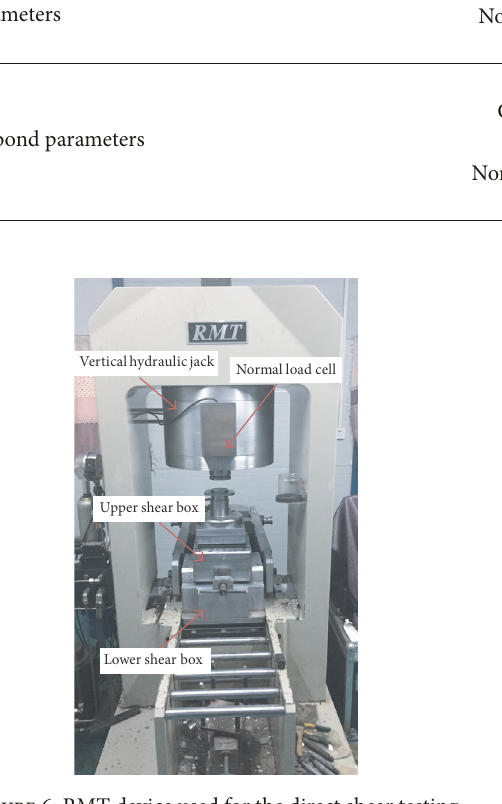
Figure 6: RMT device used for the direct shear testing.